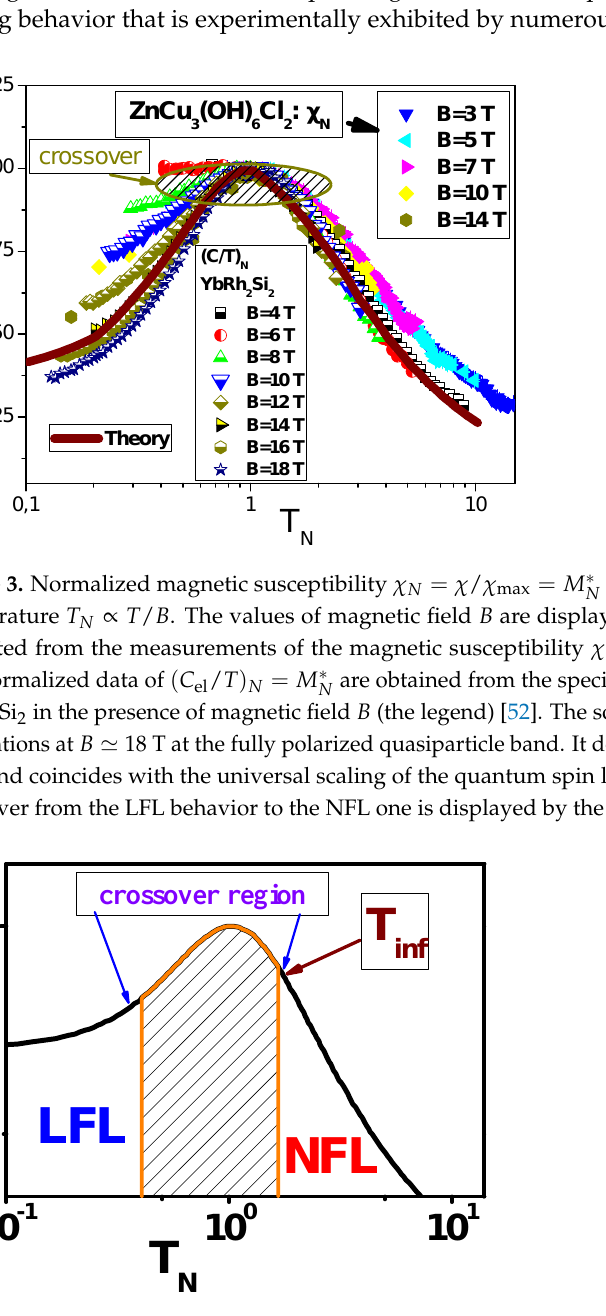
Figure 4. Schematic plot of the normalized effective mass M ∗ temperature T N = T / T M . The crossover region, at which M ∗ T N = 1, is shown by the arrows. The inflection point T inf at which the system enters the crossover region is displayed by the arrow. The LFL and NFL regions are